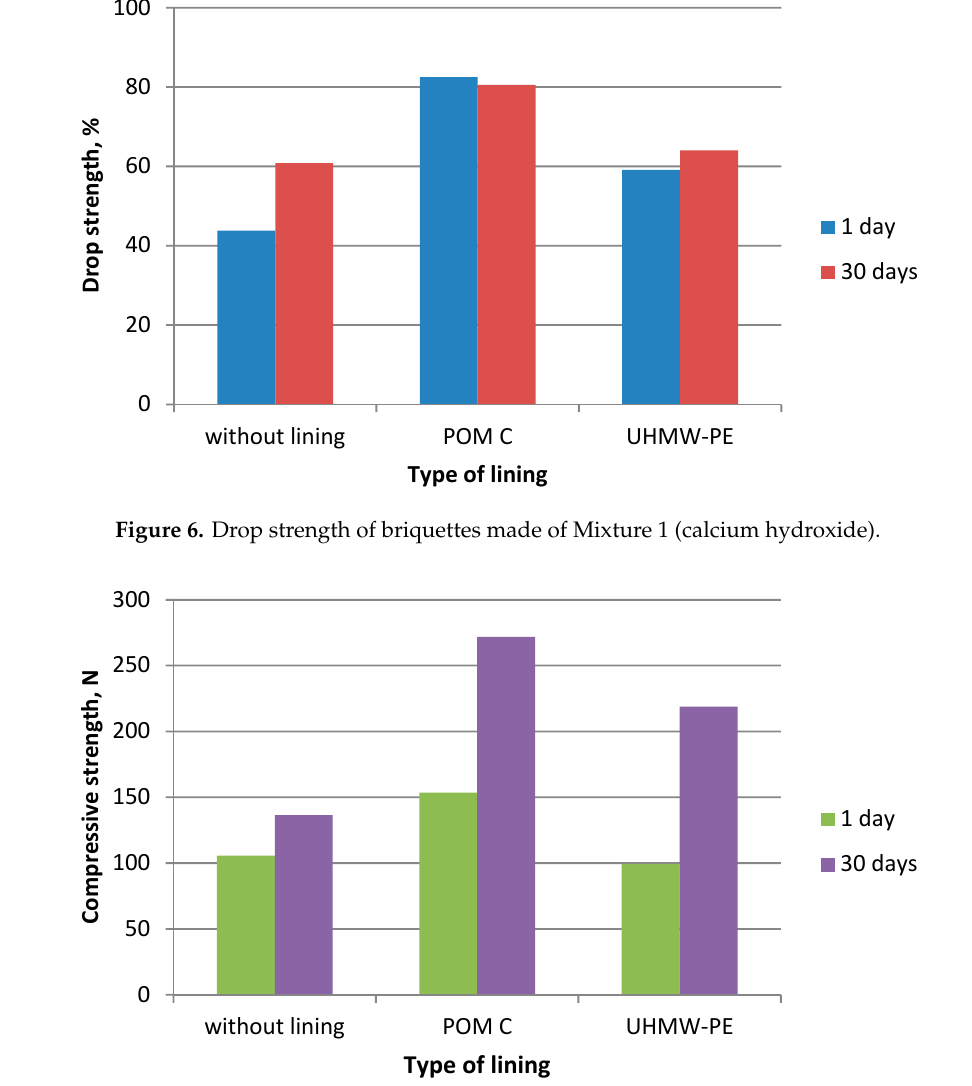
Figure 7. Compressive strength of briquettes made of Mixture 1 (calcium hydroxide).